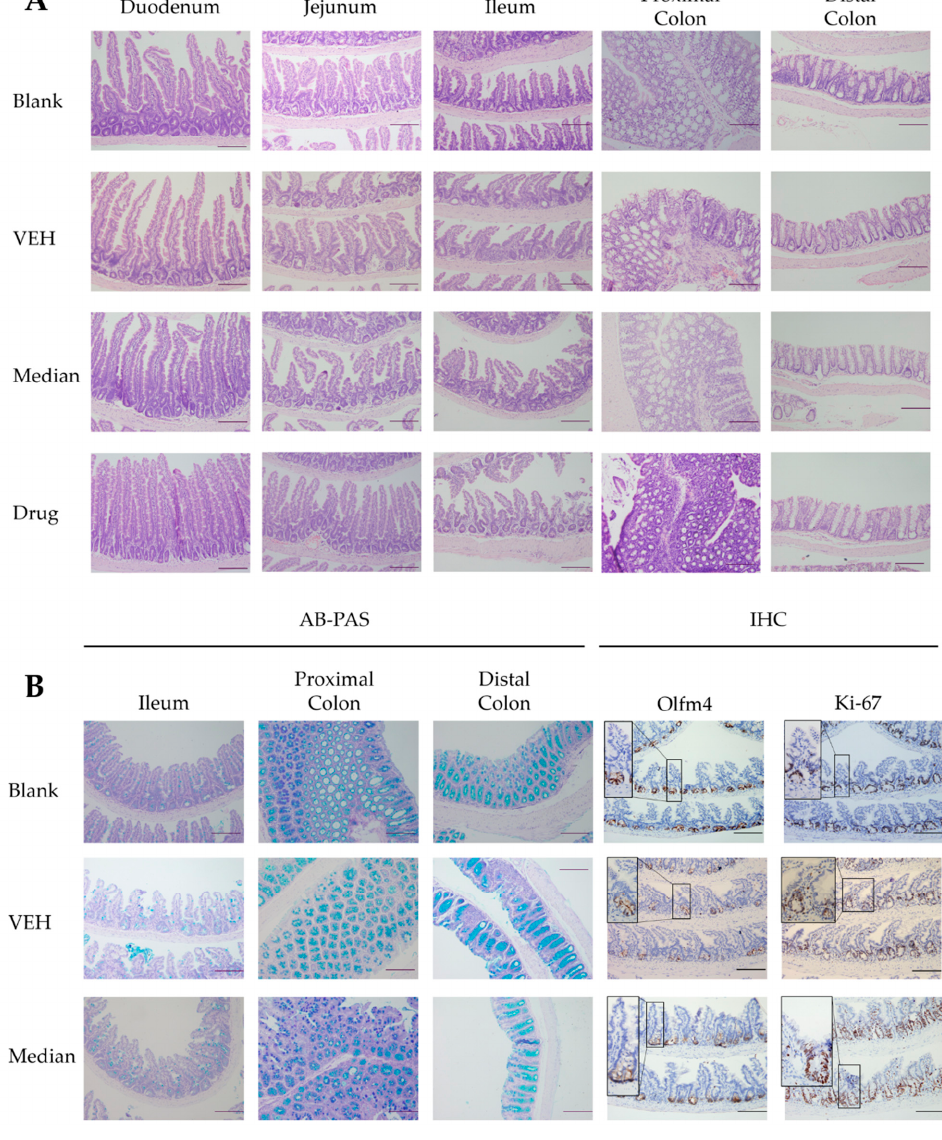
Figure 5. Staining of pathological sections. ( A ) H&E staining. ( B ). AB-PAS staining and IHC staining of Olfm 4 and Ki-67.